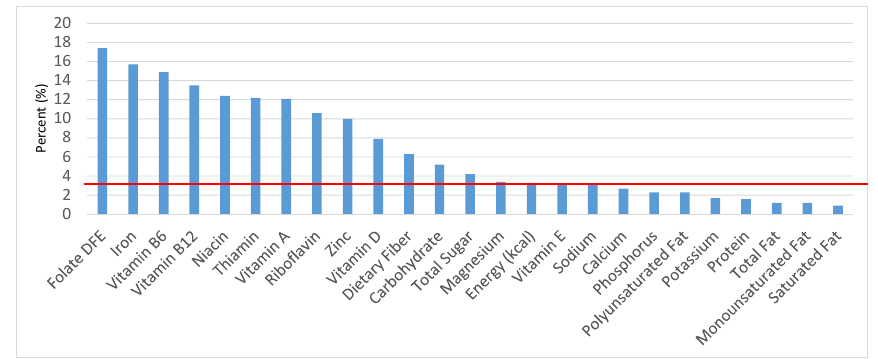
Figure 14. Ready ‐ to ‐ eat cereals as sources of energy and nutrients for children and adolescents 9–13 years old ( N = 1730, daily intake data): DFE = Dietary Folate Equivalents; solid red line represents percentage of energy (kcal) provided in the diet relative to nutrients—nutrients above the red line show the grain food’s contribution to nutrient density.